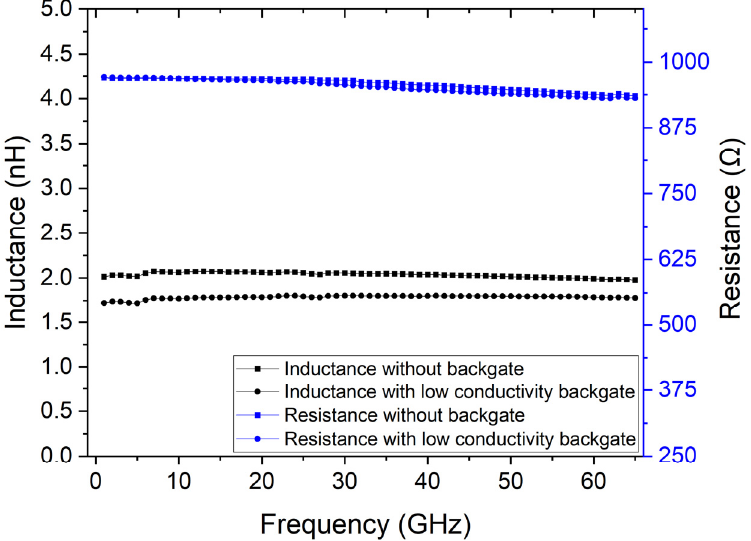
Figure 9. Comparison of the simulated and extracted DUT’s characteristics without the backgate and with a 10 nm thick backgate made of custom material with a conductivity of 2 × 10 4 S/m.